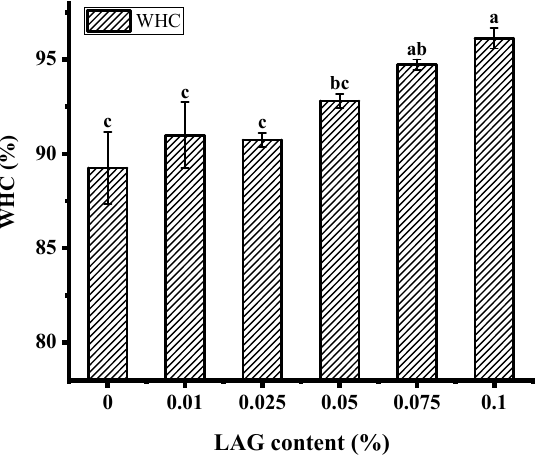
Figure 1. Water holding capacity of soy yogurt with different LAG contents. Different letters indicate that the values are significantly different ( p < 0.001).